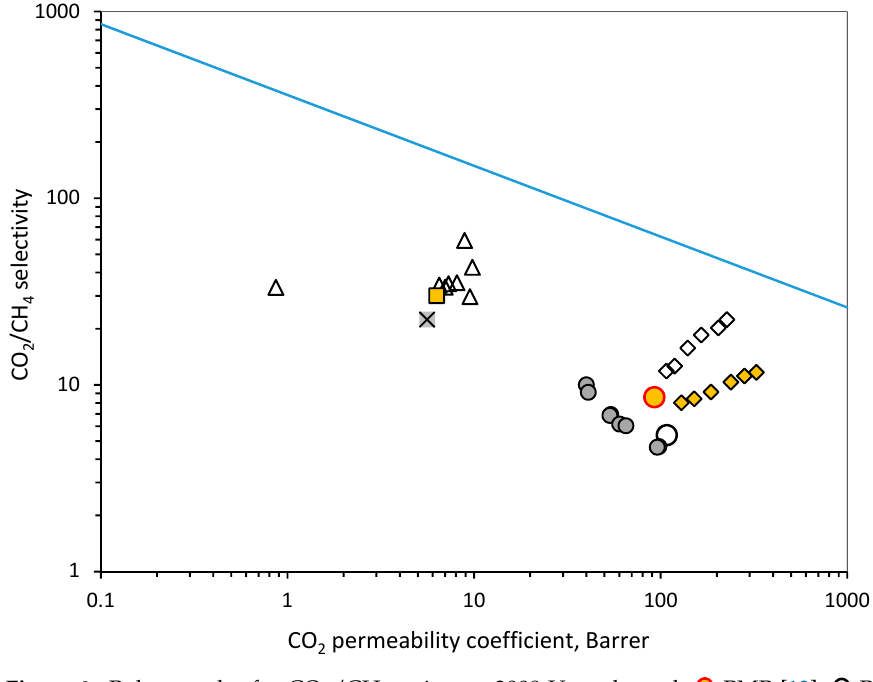
Figure 8. Robeson plot for CO 2 /CH 4 pair: 2008 Upperbound; PMP [13];